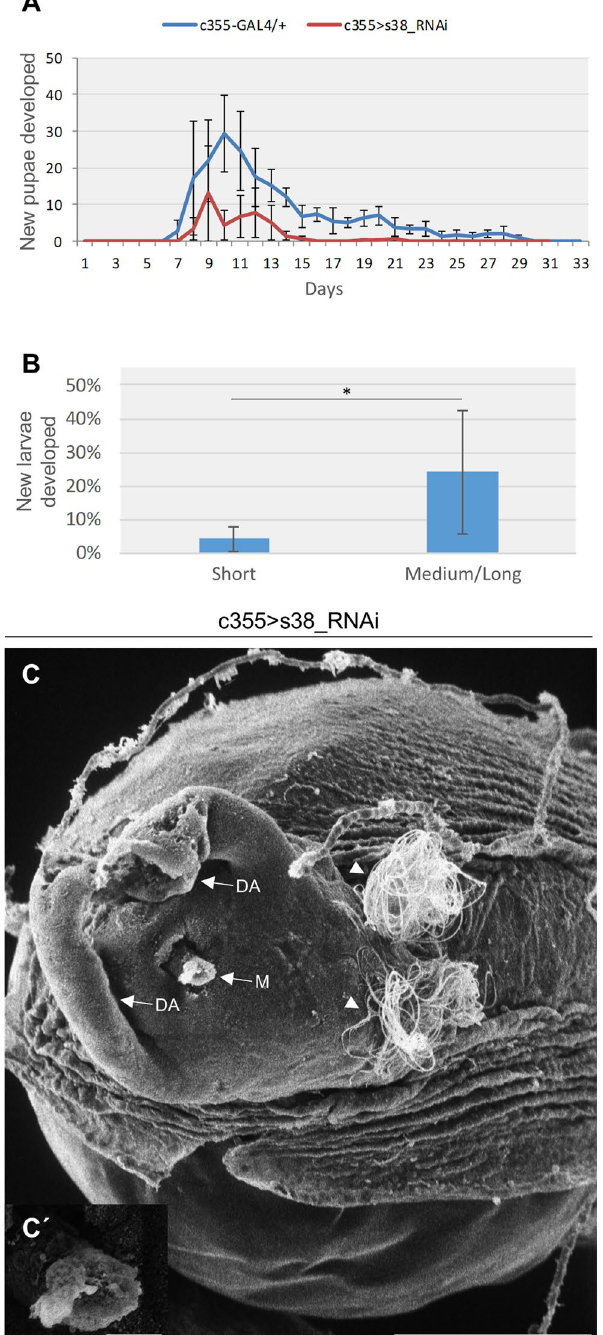
Figure 7. Follicle-cell cluster-specific downregulation of s38 protein severely harms fly’s fertility. ( A ) Eclosion- efficiency graphs of both control (c355-GAL4/ + ) (n = 60) and s38-downregulated (c355 > s38_RNAi) (n = 60) flies, for a thirty-days period, illustrating the severe reduction of fecundity capacity in s38-targeted flies. ( B ) Bar-chart presenting the eclosion-efficiency percentage of different egg categories with respect to their dorsal- appendages length. Laid eggs with (comparatively) longer in length (but still dysmorphic) dorsal appendages (n = 76) are strongly associated with increased percentage of hatching competence, as compared to eggs carrying short in length (and dysmorphic) dorsal appendages (n = 147). ( C ) Scanning electron micrograph of the operculum area of a representative s38-targeted laid egg, bearing a micropyle with blocked sperm opening and spermatozoa (white arrowheads) on its surface. (C ′ ) Higher-magnification image of the clogged micropyle. M: Micropyle and DAs: Dorsal Appendages. Scale Bars: 50 μ m in C; 5 μ m in C ′ . * p <